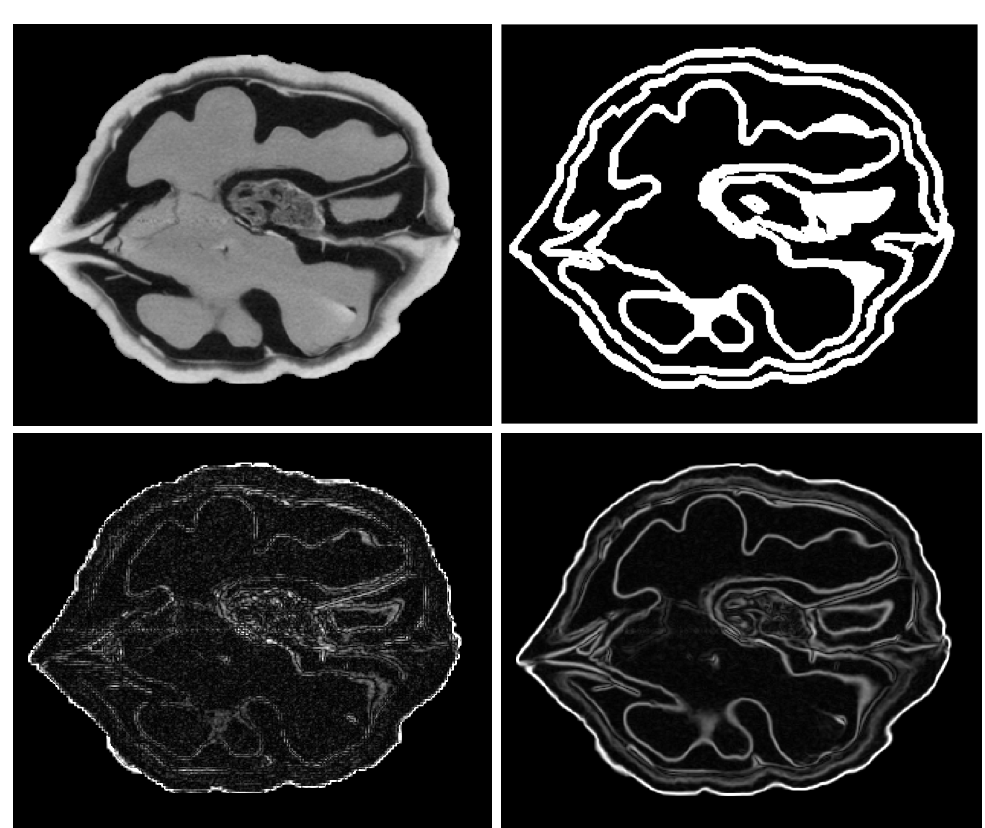
Figure 4. Upper left : a slice of the walnut CT I . Upper right : the borders δ M computed as in Equation (35) at the same slice. Bottom left : the pointwise absolute error E (as in Equation (34)) in ANTs linear interpolation. Bottom right : ∇ I , the norm of the gradient of the original image computed with Equation